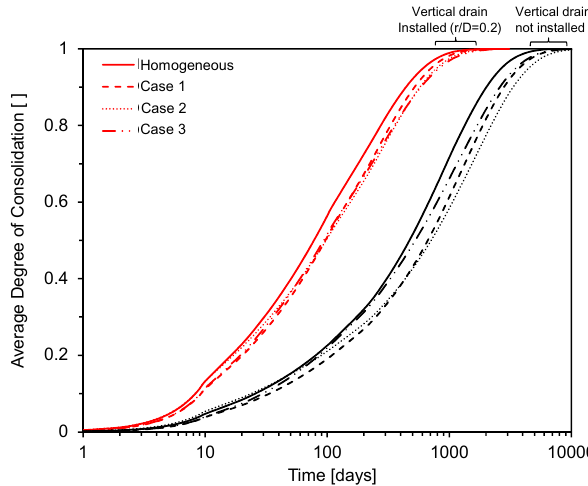
Figure 5. Consolidation of the correlated random soils with different drainage conditions. Spatial variation of material properties for cases 1, 2, and 3, as shown in Figure 4.